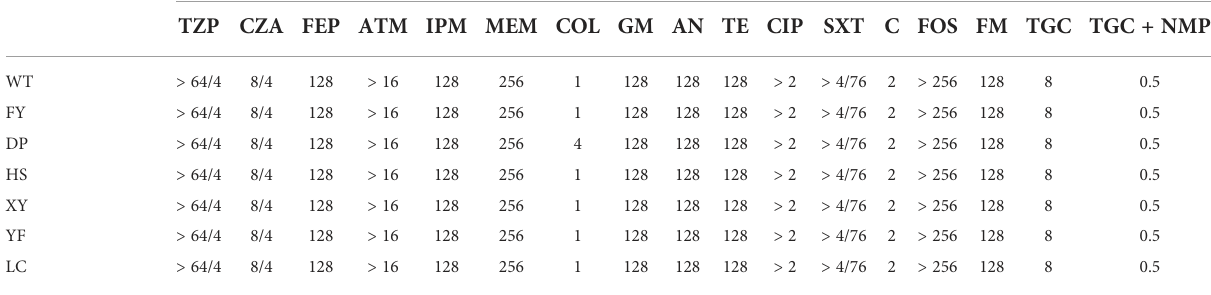
TABLE 2 Antimicrobial susceptibility pro fi les of seven XDR-HvKp strains.